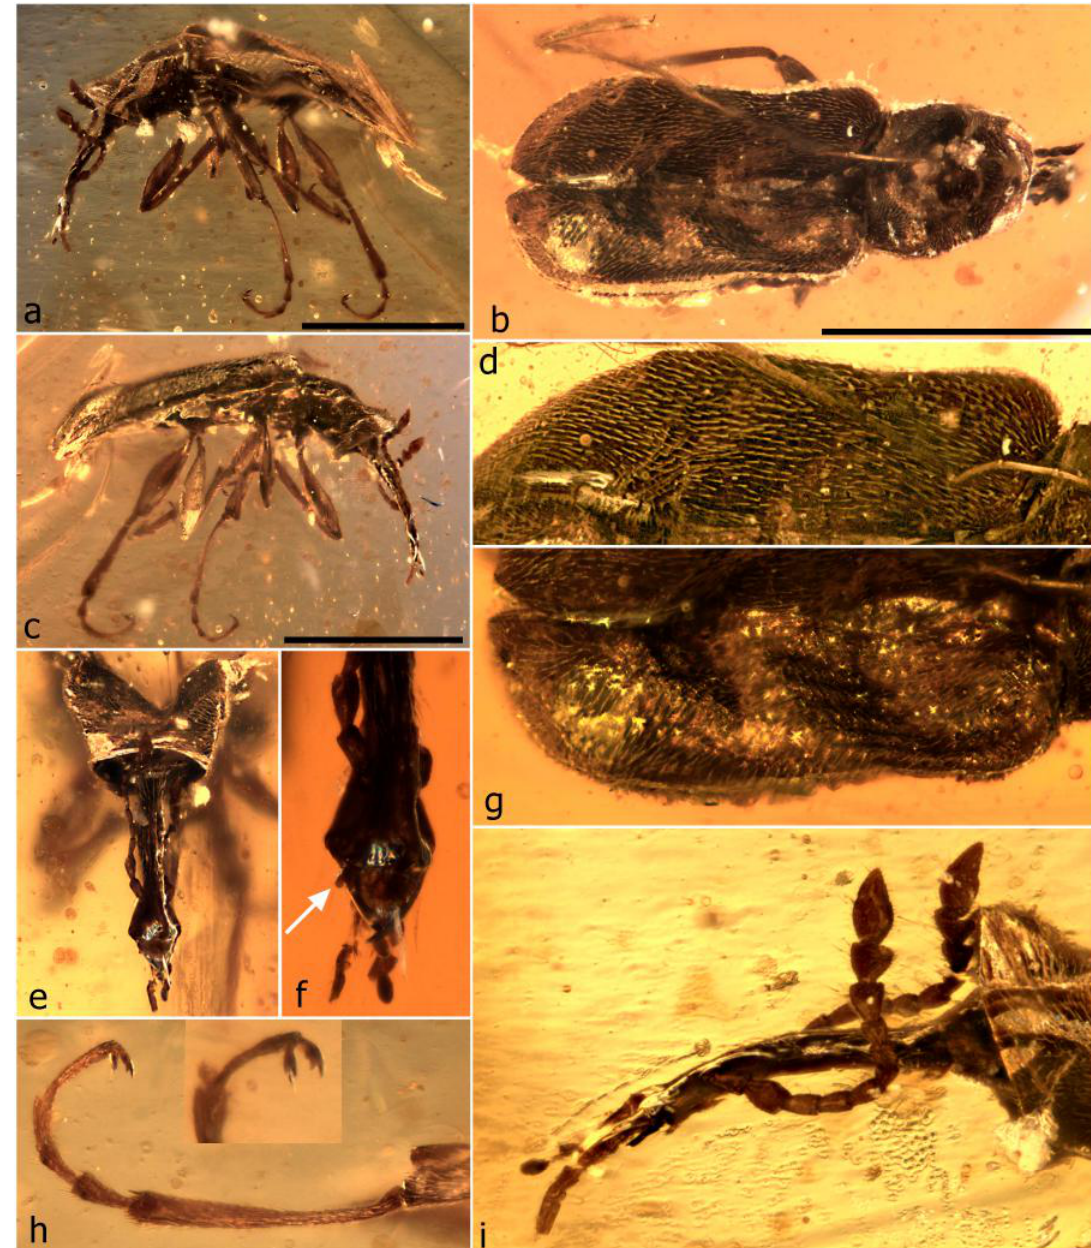
Figure 15. Guillermorhinus longitarsis sp. n., holotype. Habitus, left lateral ( a ); habitus, dorsal ( b ); habitus, right lateral ( c ); left elytron, dorsal ( d ); rostrum, dorsal ( e ); apex of rostrum and mandibles showing exposed postmental process (arrow), dorsal ( f ); right elytron showing faint striae, dorsal ( g ); left mestotibia and tarsus, insert showing detail of tarsal claw ( h ); head, rostrum and antenna, left lateral ( i ). Scale bars: 1.0 mm (a–c).